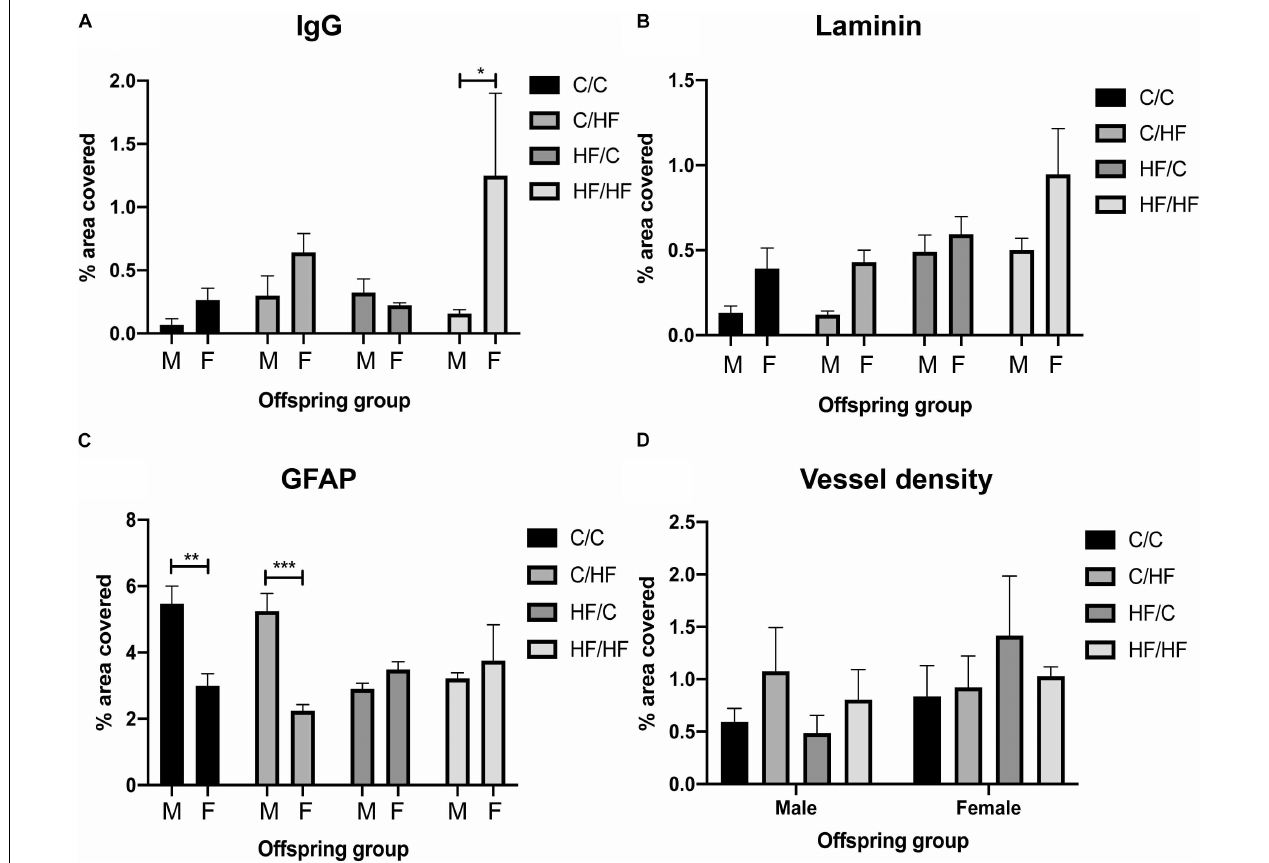
FIGURE 5 | Comparison of blood–brain barrier integrity and vessel density between male and female offspring. (A–C) Quantification of hippocampal area positive for IgG extravasation (A) , laminin (B) and GFAP (C) in 16-month old male and female C/C, C/HF, HF/C and HF/HF mice. (D) Vessel density in hippocampus of male and female offspring. Data represent mean ± SEM. ∗ p < 0.05, ∗∗ p < 0.01, ∗∗∗ p < 0.001, two-way ANOVA with Holm–Sidak post hoc